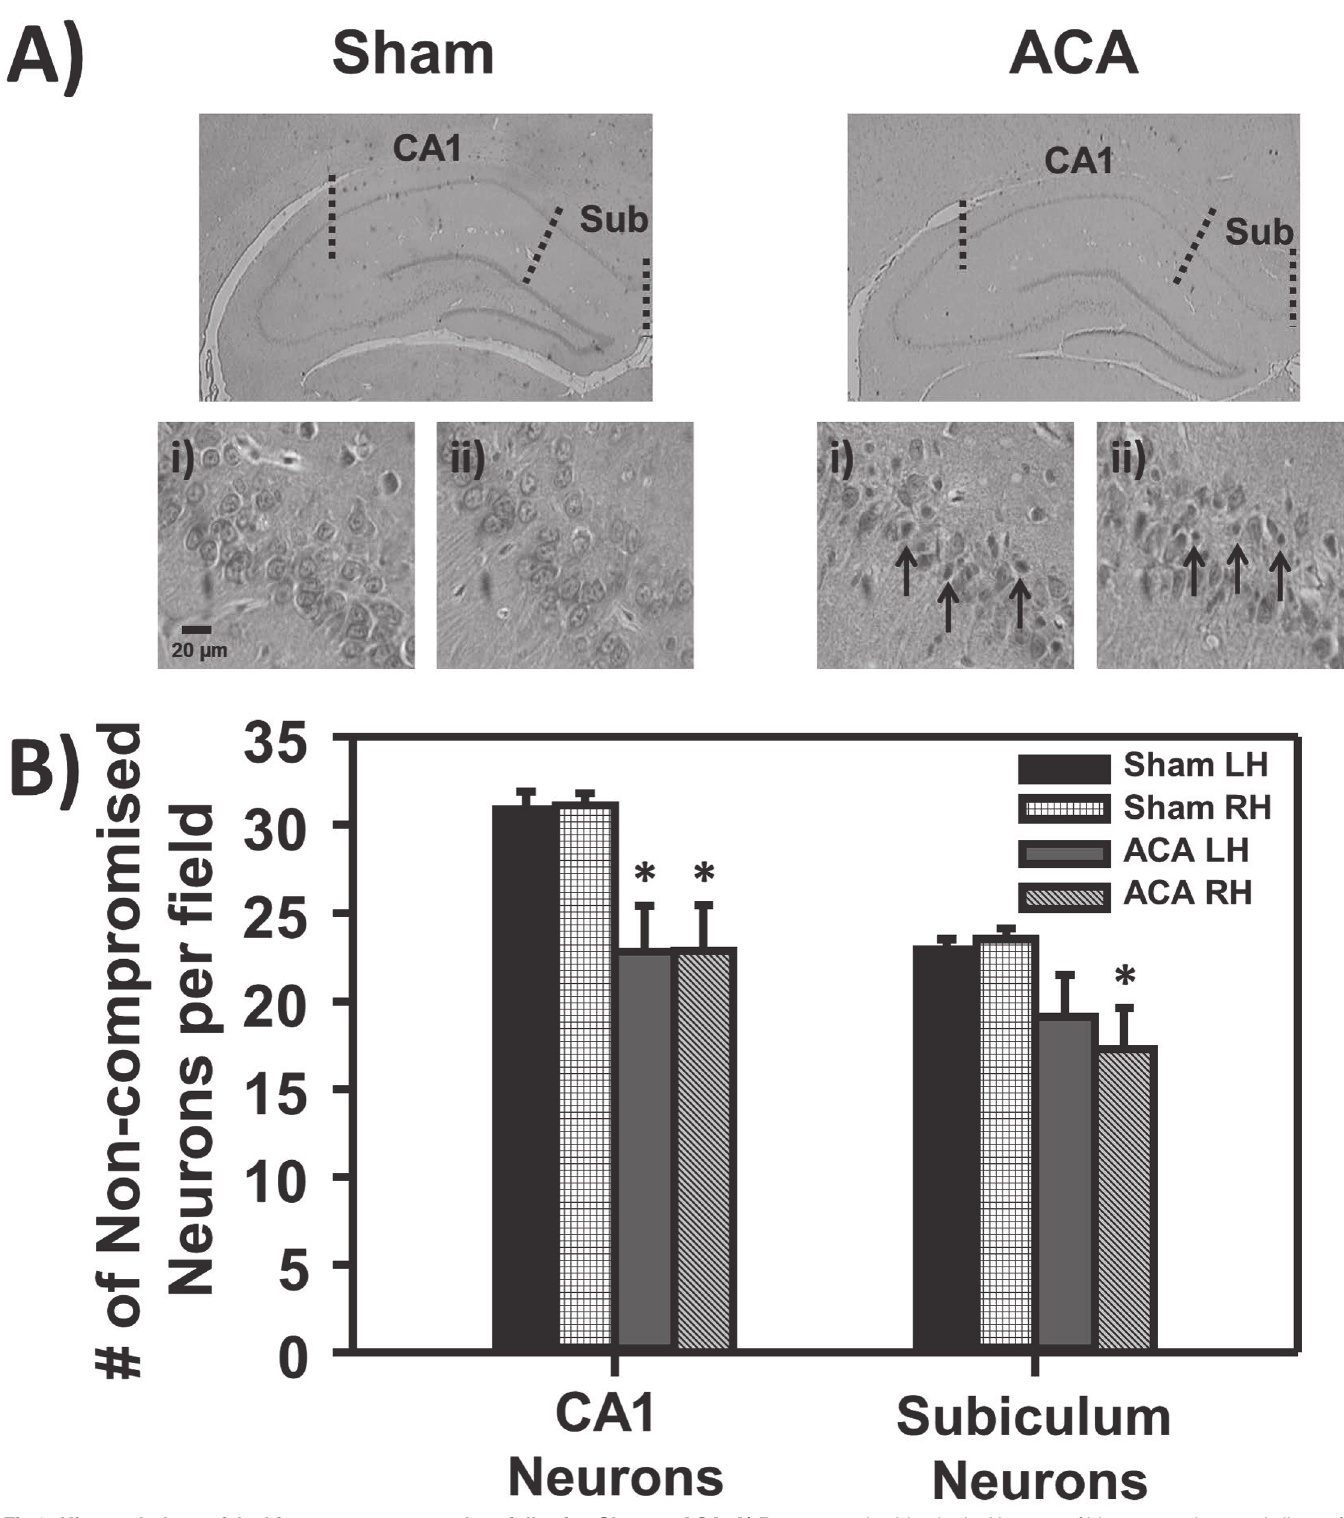
Fig 2. Histopathology of the hippocampus seven days following Sham or ACA. A) Representative histological images of hippocampal coronal slices of Sham and ACA animals with 40X images of the i) CA1 and ii) subiculum region. There was a visible increase in small pyknotic and eosinophilic cells (arrows) following ACA in the CA1 and subiculum regions. B) Bar graph depicting the number of non-compromised neurons per field to left (LH) or right (RH)